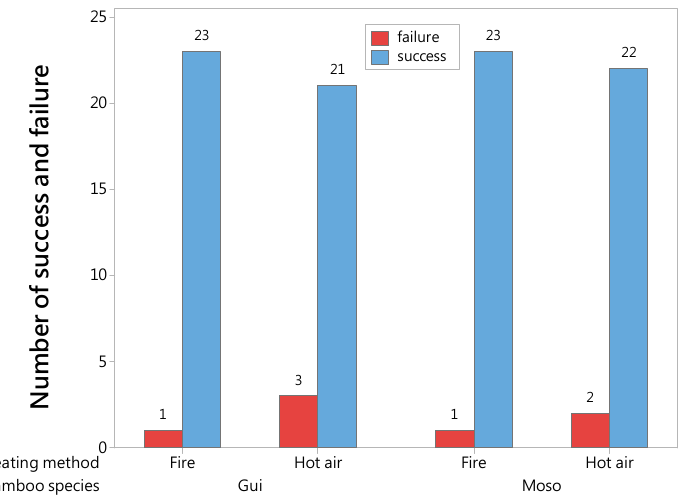
speciesHeating method Bamboo Figure 4. The number of successes and failures of various bamboo and heating Figure 4. The number of successes and failures of various bamboo and heating methods.